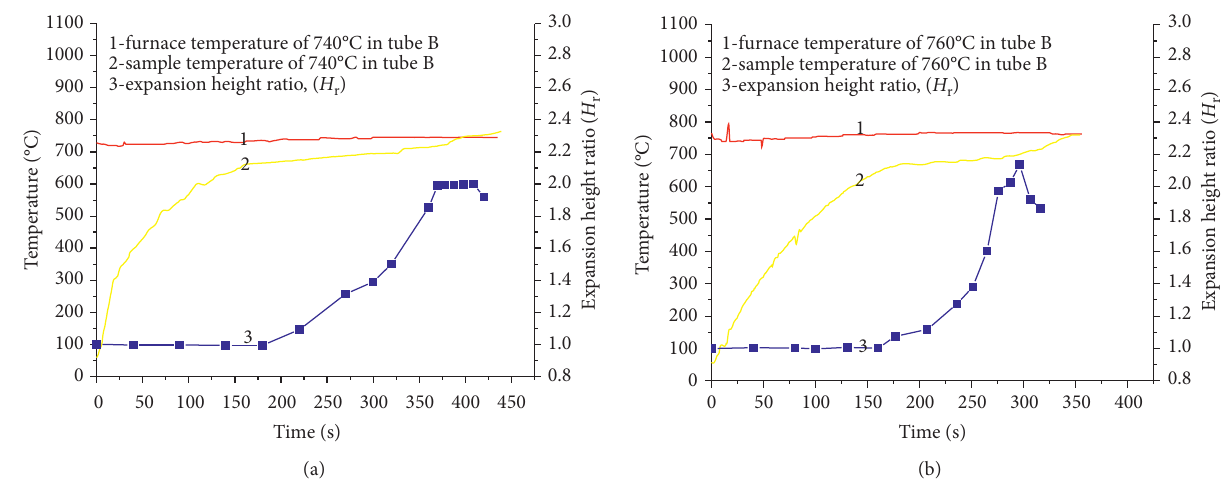
Figure 3: Temperature rise-expansion curves of the sample in pipe B at furnace temperatures of 740 ° C (a) and 760 ° C